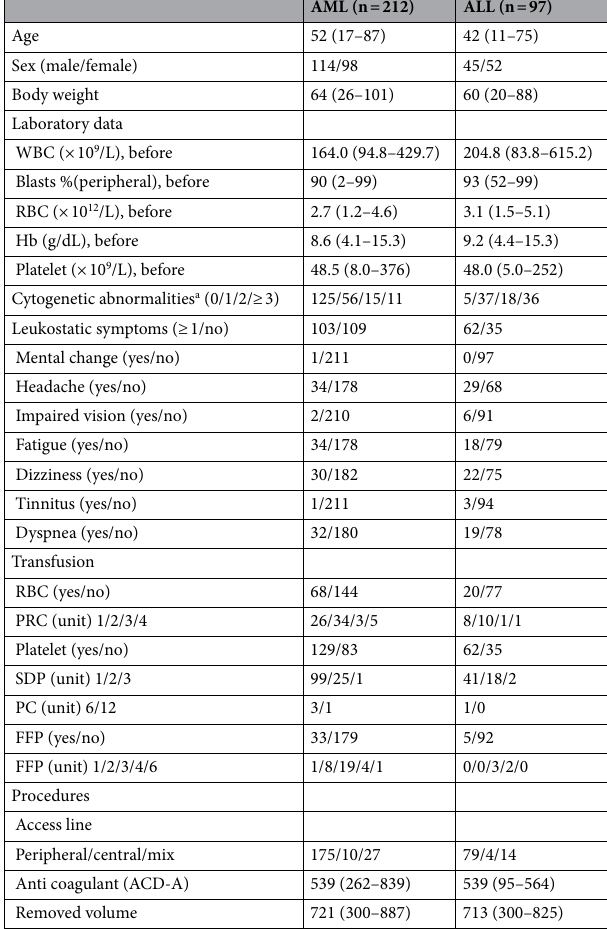
Table 1. Baseline characteristics of acute myeloid leukaemia (AML), acute lymphoblastic leukaemia (ALL) groups. WBC white blood cell, RBC red blood cell, Hb haemoglobin, PRC packed red blood cells, SDP